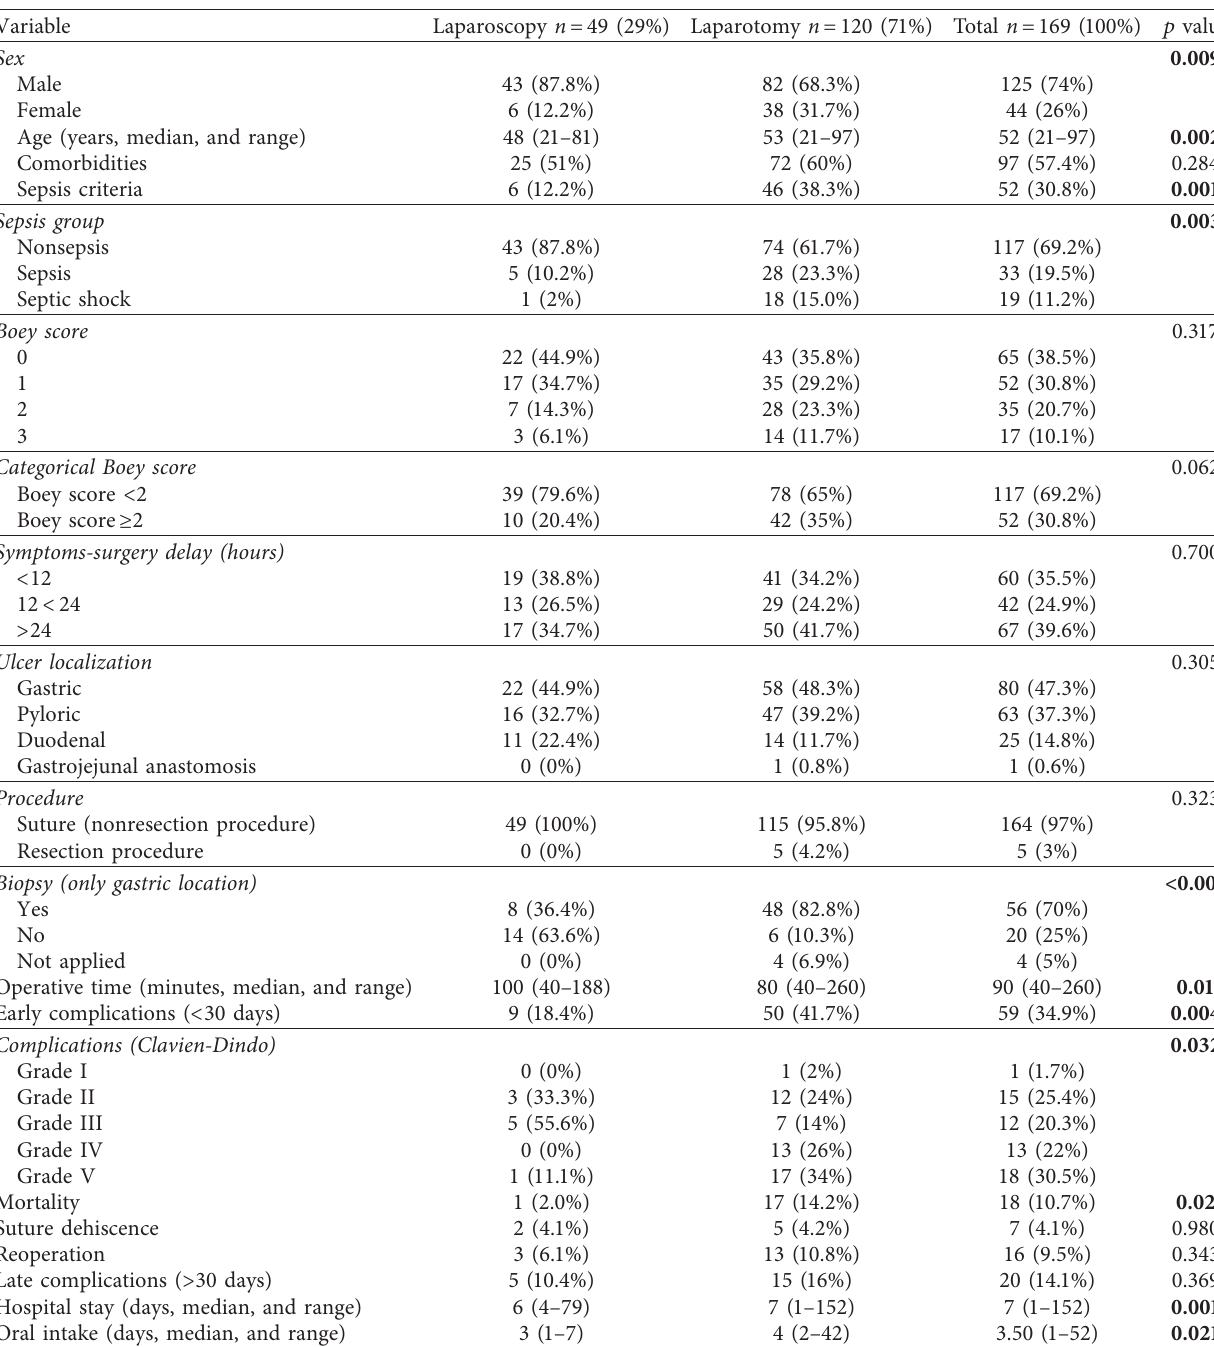
Table 1: Surgical